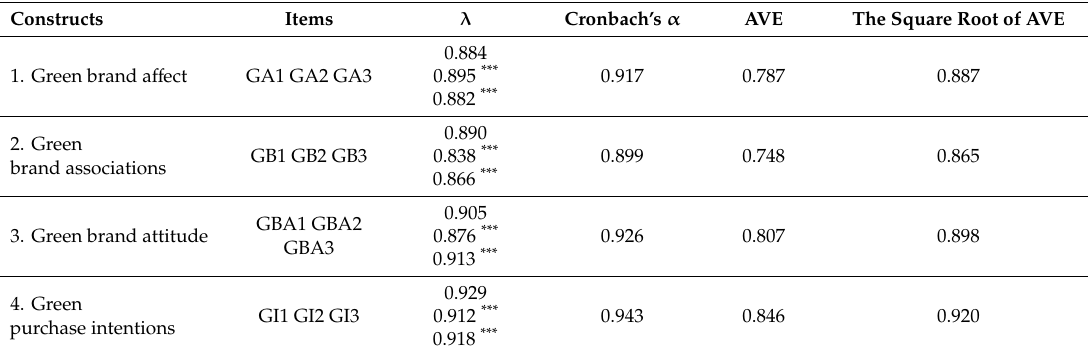
Table 4. The items’ loadings ( λ ) and the constructs’ Cronbach’s α coe ffi cients and average variance extracted